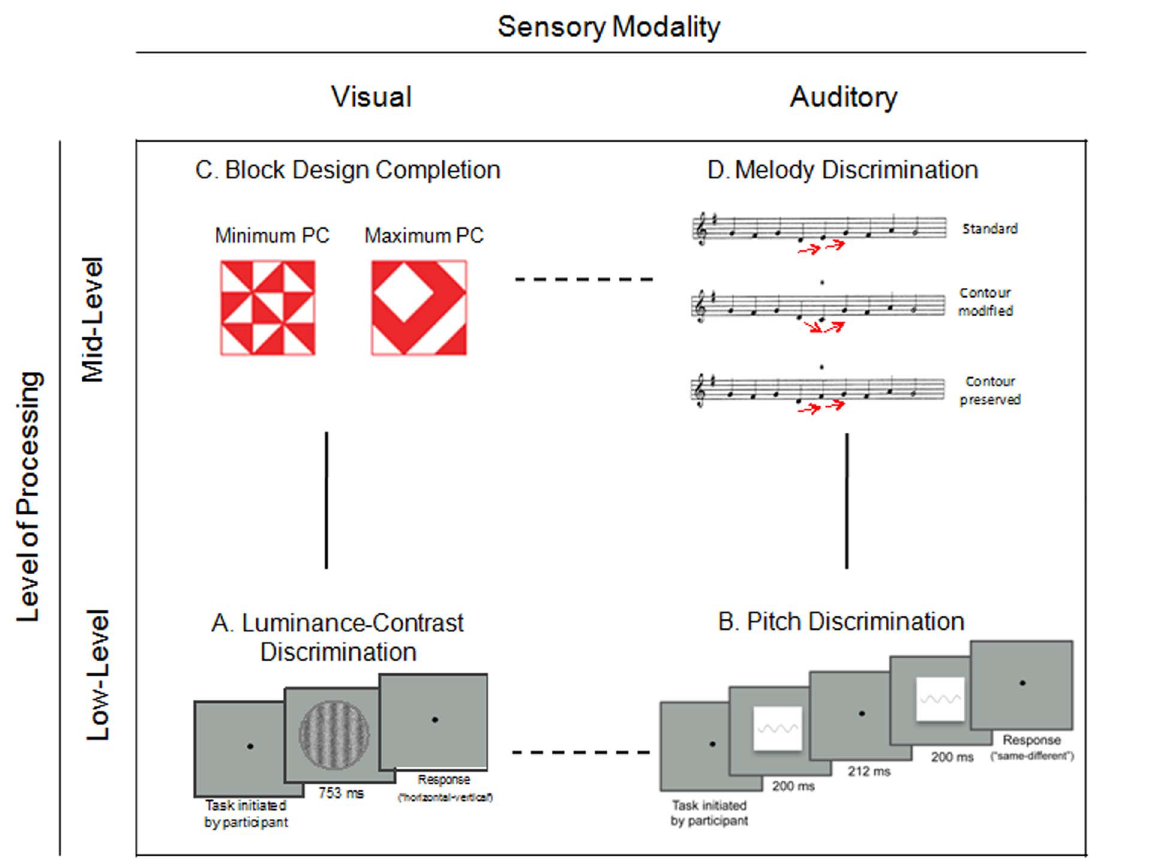
Figure 2. Schematic representation of the study’s factorial design and presentation of experimental stimuli and tasks. The four experimental tasks are presented in each quadrant. Each task is characterized by a sensory modality (visual or auditory) and by a level of cortical processing engaged during task completion (low- or mid-level). A. Luminance-contrast (LC) discrimination: gratings were presented for 753 ms each and separated by an inter-stimulus interval of 271 ms, during which a noise mask was presented to minimize spatial after effects. B. Pitch discrimination: pure tones were presented for 200 ms each and separated by an inter-stimulus interval of 212 ms. C. Block design completion: examples of minimum and maximum perceptual cohesiveness (PC) models. D. Melody discrimination: examples of a standard melody compared to contour modified and contour preserved conditions. Red arrows represent contour direction. Lines represent relationships of interest in the current study. Full lines: unimodal relationships, between levels of processing; Dotted lines: plurimodal relationships, within levels of processing.